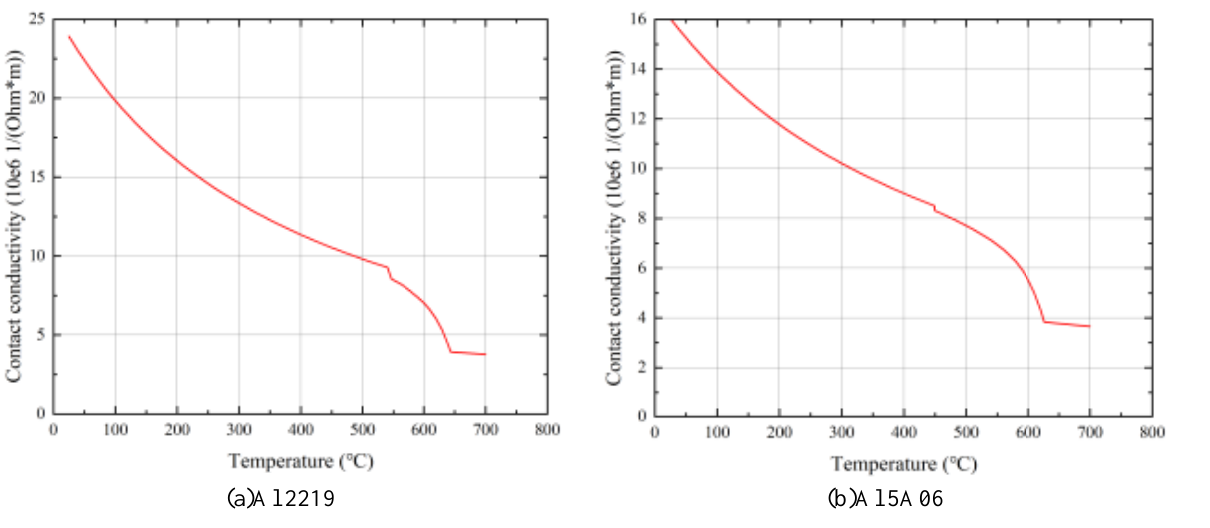
Figure 7. ( a ) contact conductivity between 2219 and electrode, ( b ) contact conductivity between 5A06 and electrode.